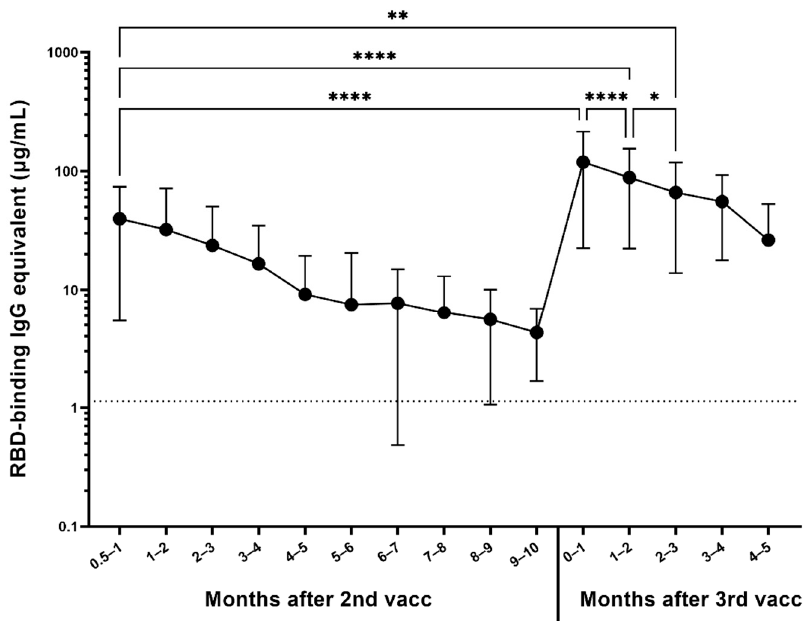
Figure 3. Response to 3rd dose of mRNA vaccines (n = 306). Participants are represented regardless of pre-immunity. Significant increase in anti-RBD IgG antibody level was observed between the last available pre-booster timepoint and the timepoint within the first month after the booster (**** p < 0.0001). The difference between the timepoint 2–4 weeks after the second dose and the timepoint within the first month after the booster was also significant (**** p < 0.0001). Month-to- month antibody decay is significant for the first 3 months after the booster (**** p < 0.0001 for the first two months, * p < 0.05 between the second and the third month), at which point the antibody level was still significantly higher than 2–4 weeks after the second dose (** p =